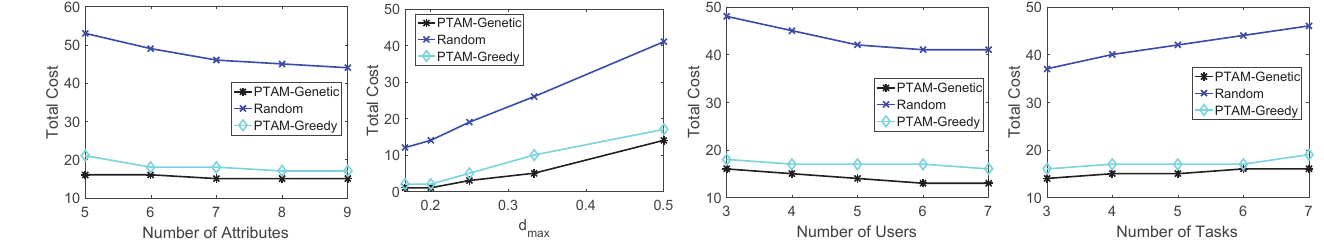
Figure 9. Performance comparisons on the roma/taxi trace set.